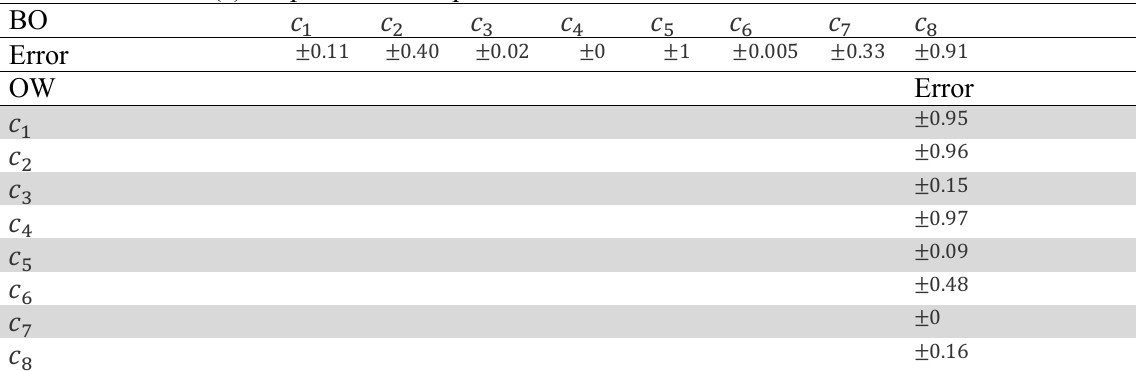
The value of errors( e ) for part 1 in example 4